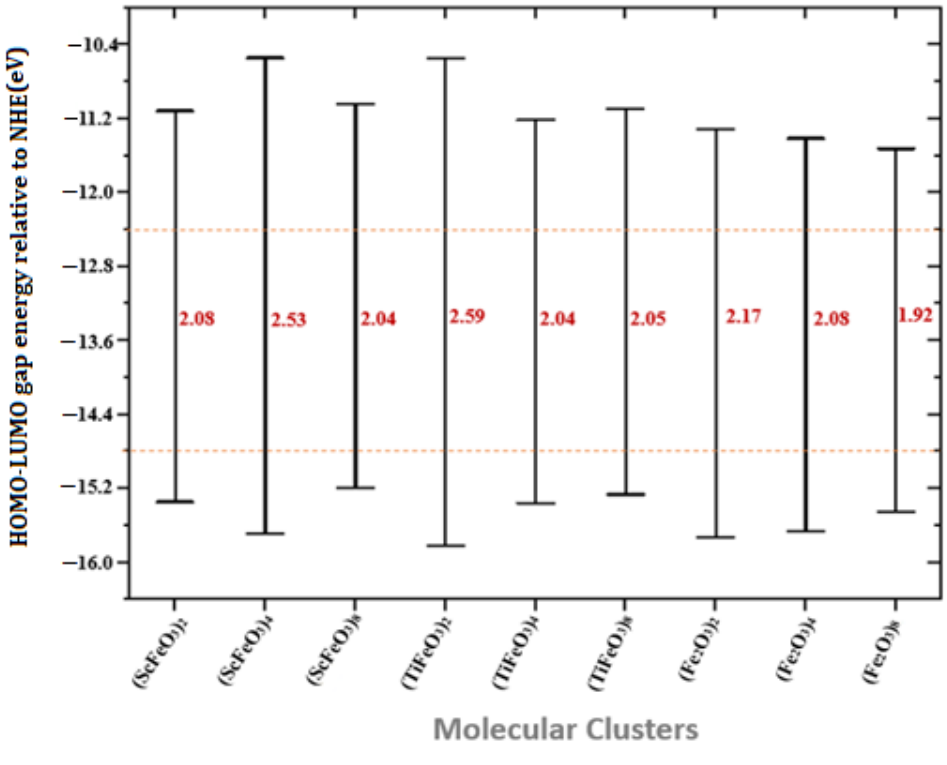
Figure 7. The computed values of gap with HOMO and LUMO positioned relative to normal hydrogen electrode for (TMFeO (cid:2871) ) (cid:2934) clusters with x = 2, 4, 8 and TM = Sc, Ti, Fe.